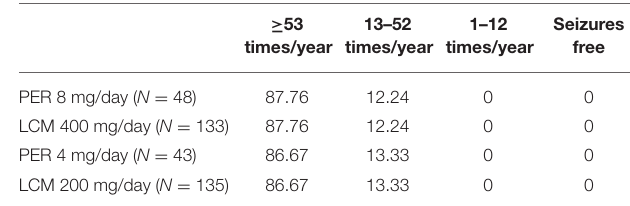
TABLE 1 | Baseline seizure distribution in Markov model, %.